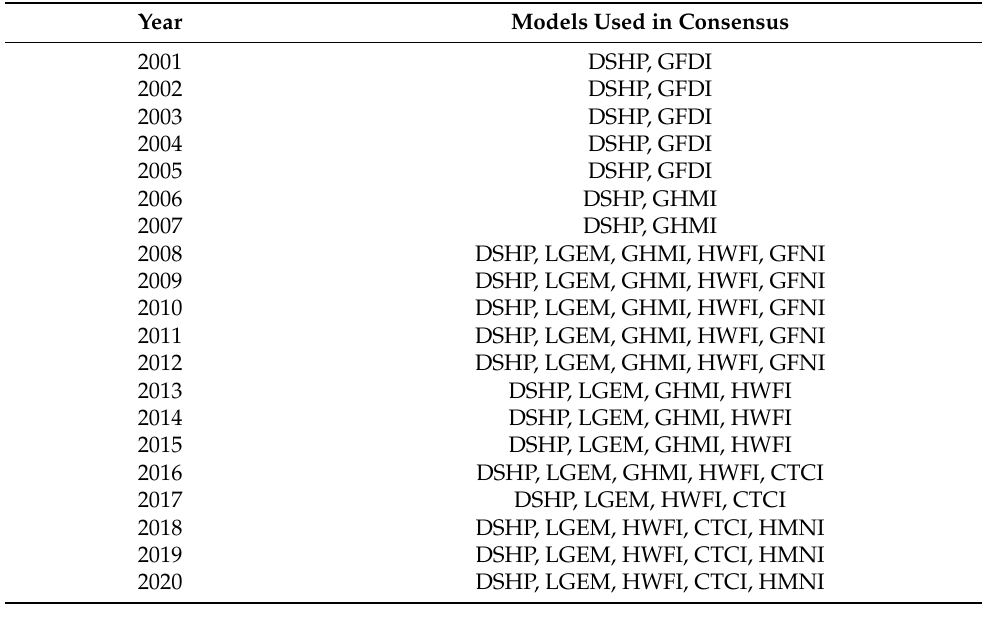
Table 9. Annual composition of NHC’s operational intensity consensus.